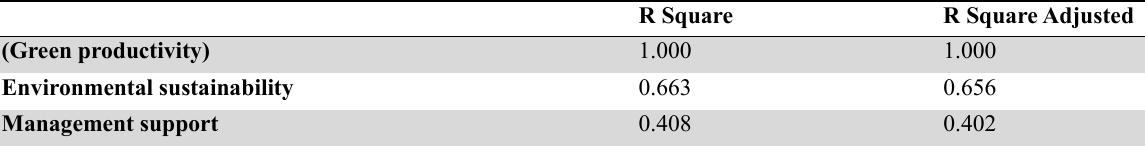
R Square R Square Adjusted